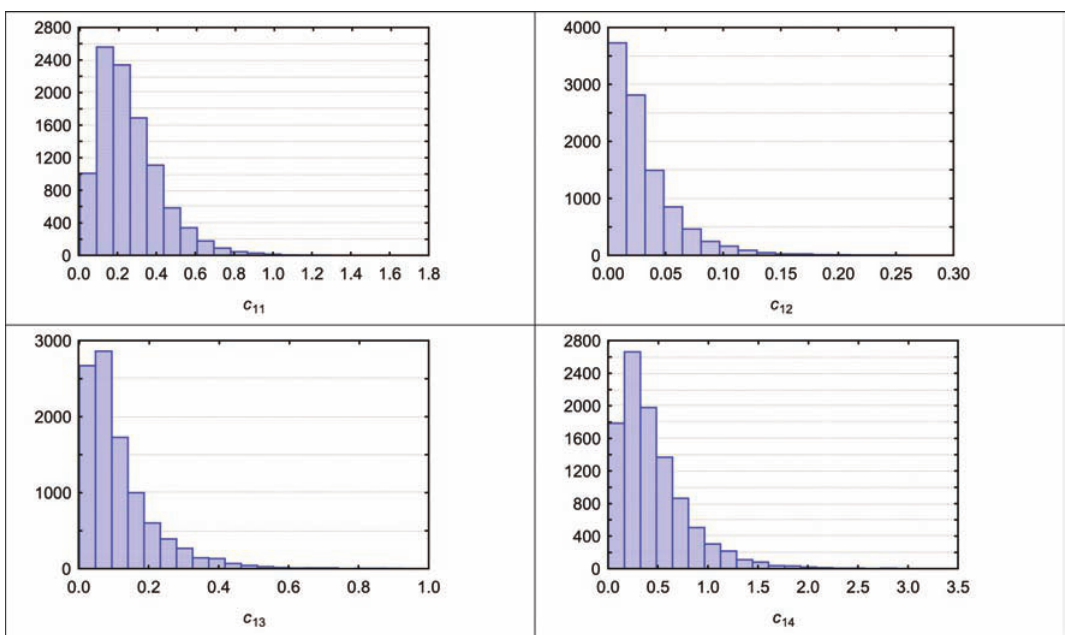
c ,  c ,  c , and  c of the components 11, l 12, l 13, l 14, l